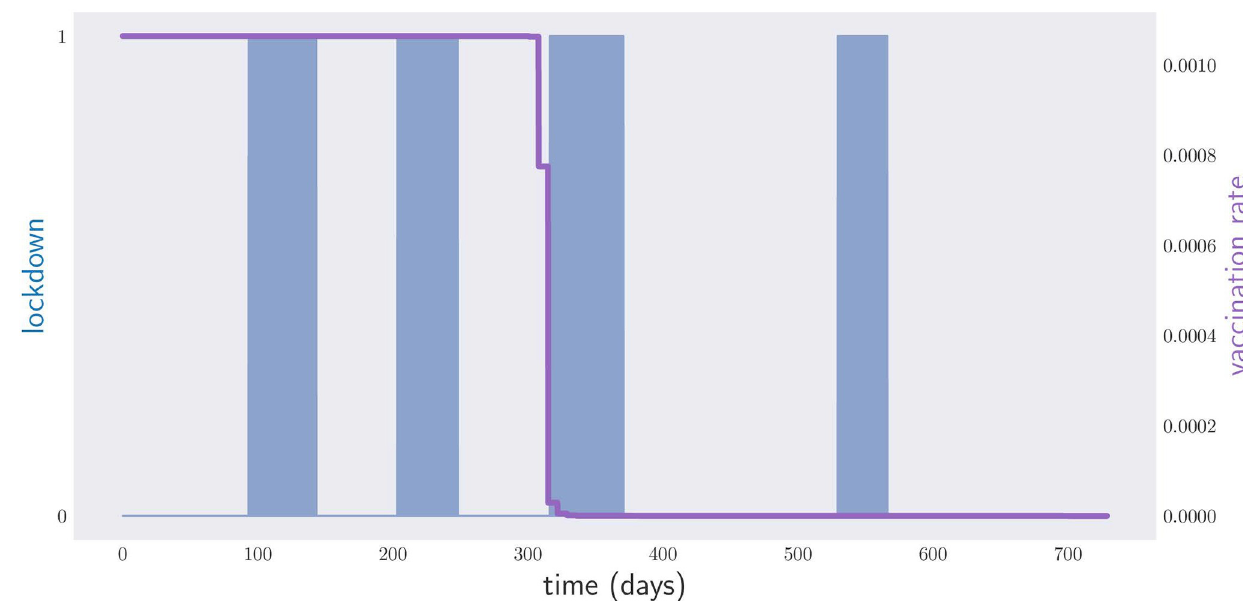
Fig 7. Lockdown times (blue) and vaccination rates (magenta) for a period of two years.